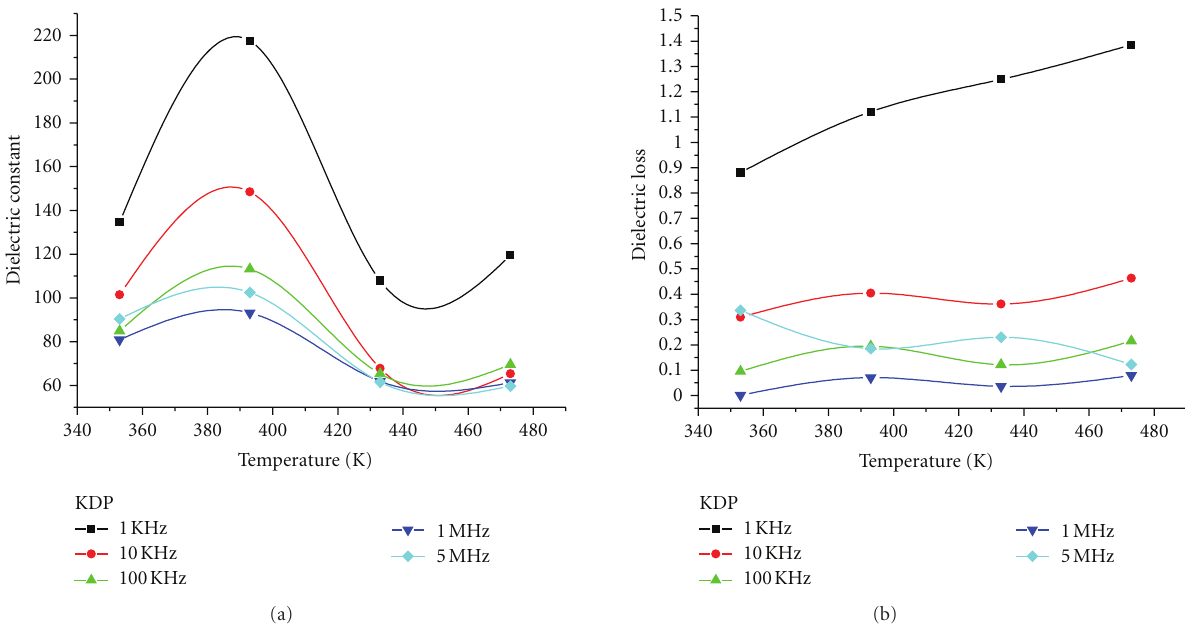
Figure 4: (a) Variation of dielectric constant with temperature for all frequencies (pure KDP). (b) Variation of dielectric loss with temperature for all frequencies (pure KDP).